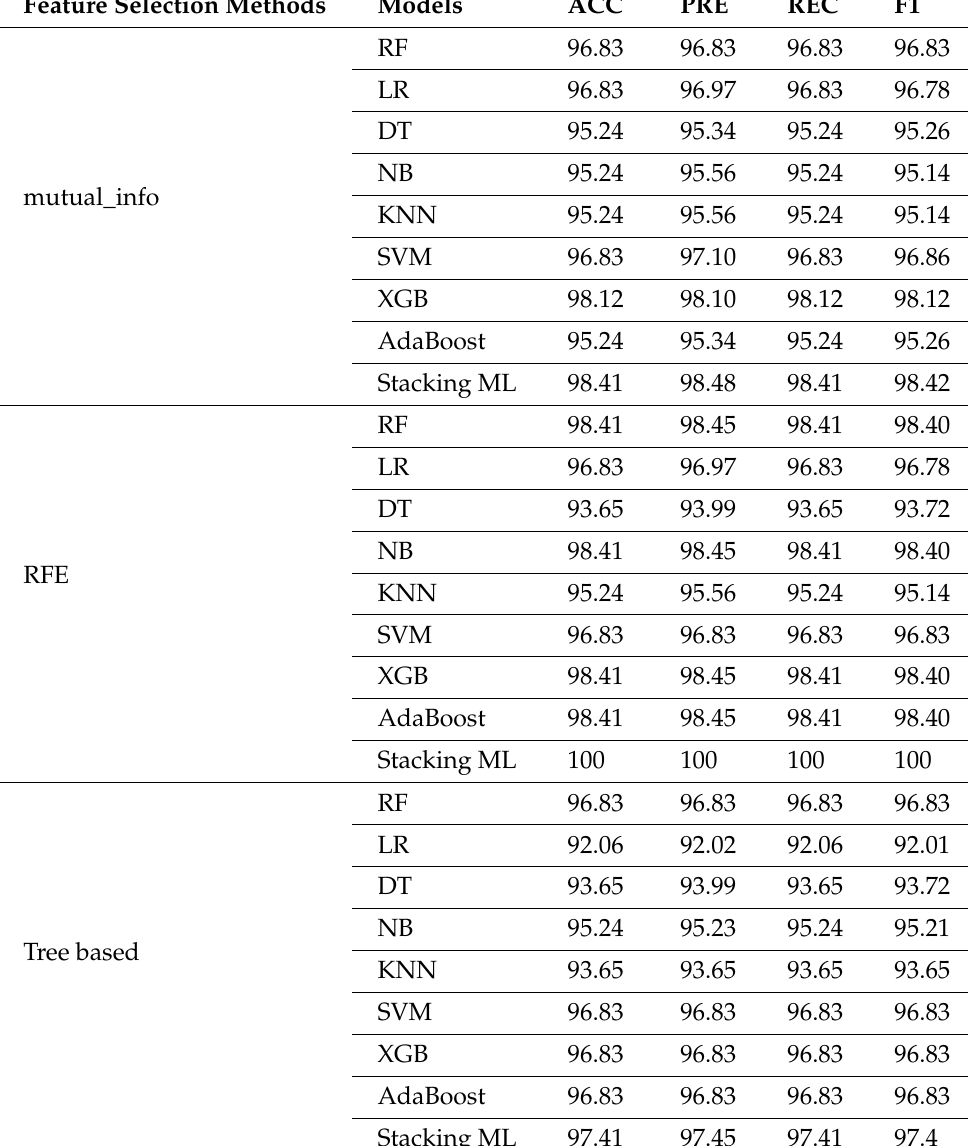
Table 2. Performance of the classifiers with selected features using splitting